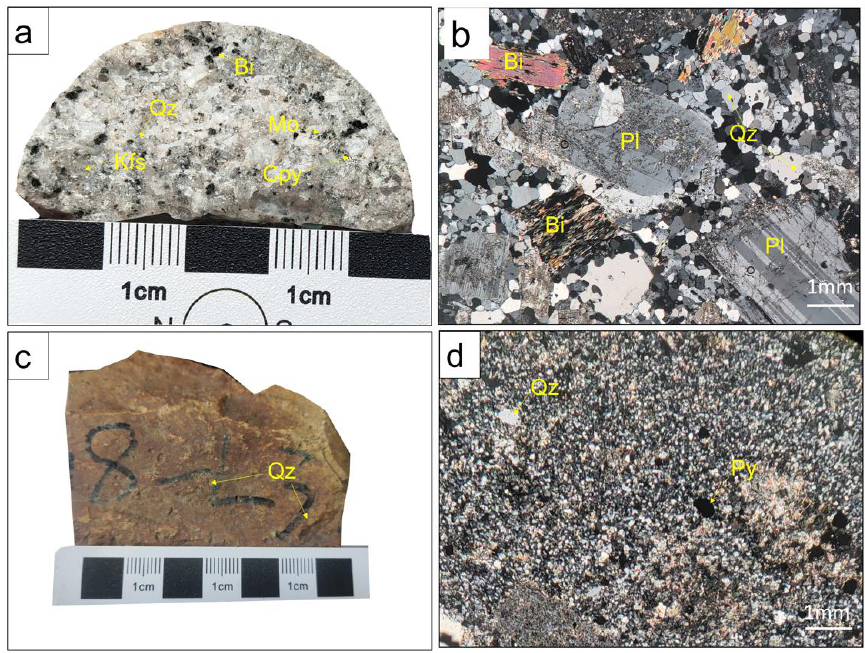
Figure 3. Photographs of representative rock samples of Demingding deposit and relevant